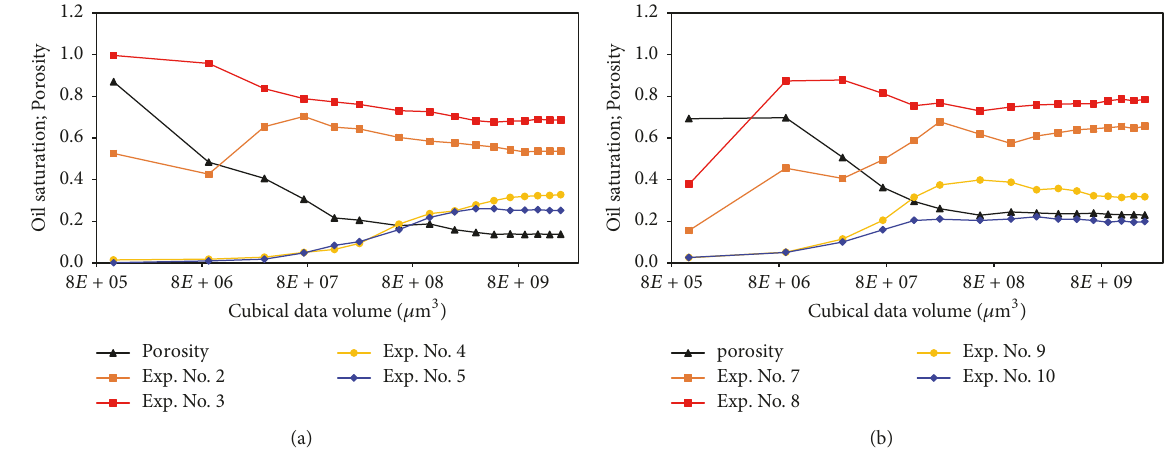
Figure 3: Variation of porosity and oil saturation with various subsample volumes for (a) water-wet and (b) oil-wet plug